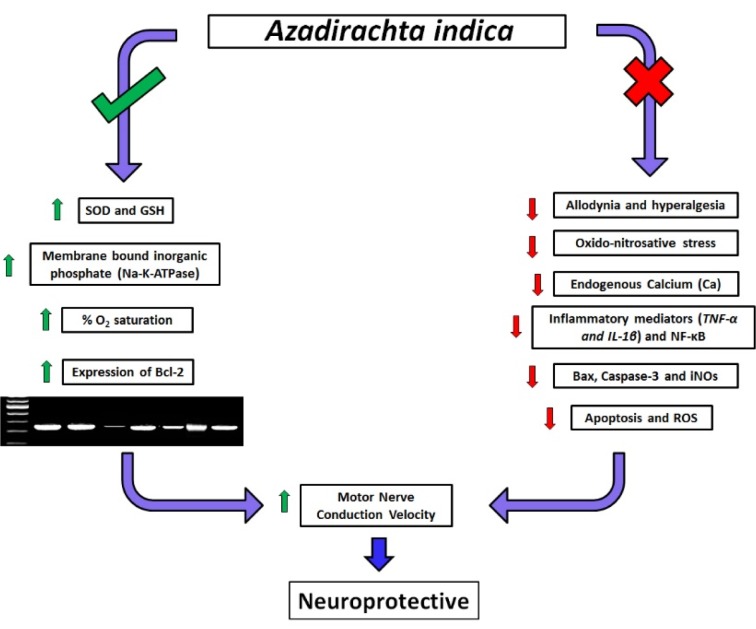
Graphical abstract